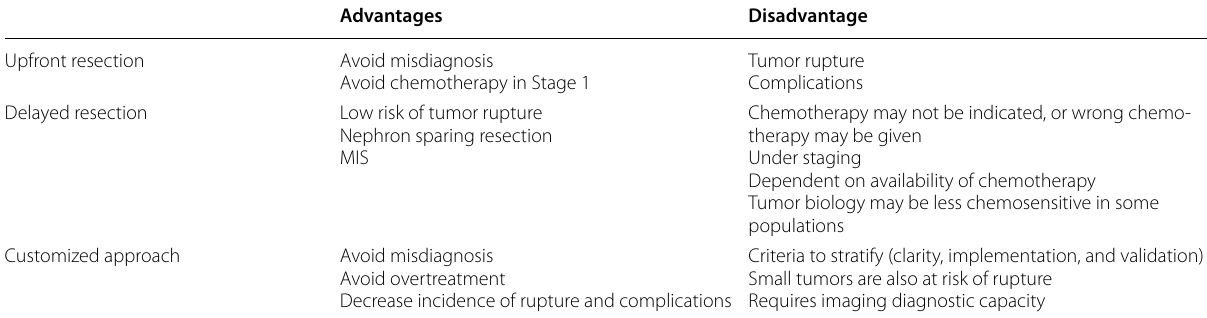
Table 2 Potential clinical advantages and disadvantages of Wilms’ tumor resection